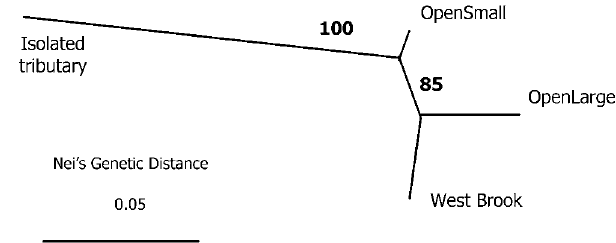
Figure 1. Population genetic structure among the Open system and the Isolated tributary. Numbers represent the percentage of bootstrap runs supporting the tree structure.